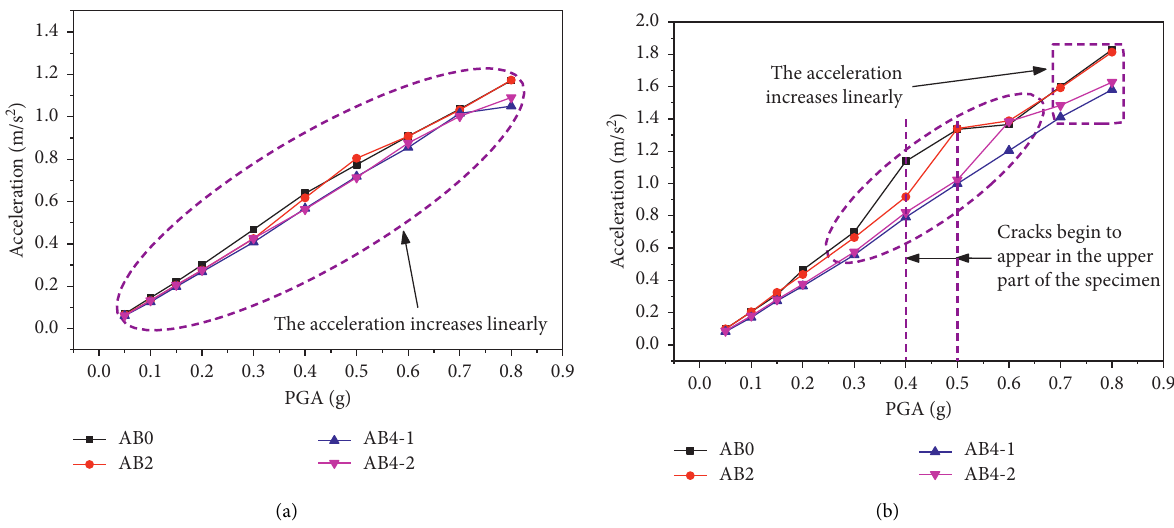
Figure 10: Peak acceleration of IDB wall at different positions. (a) In the middle of the IDB wall. (b) At the top of the IDB